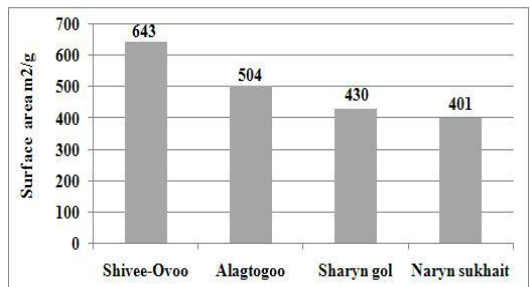
Figure 2. The surface area of Shivee-Ovoo, Alagtogoo, Sharyn gol and Naryn sukhait active carbons. (activation time 220 min)